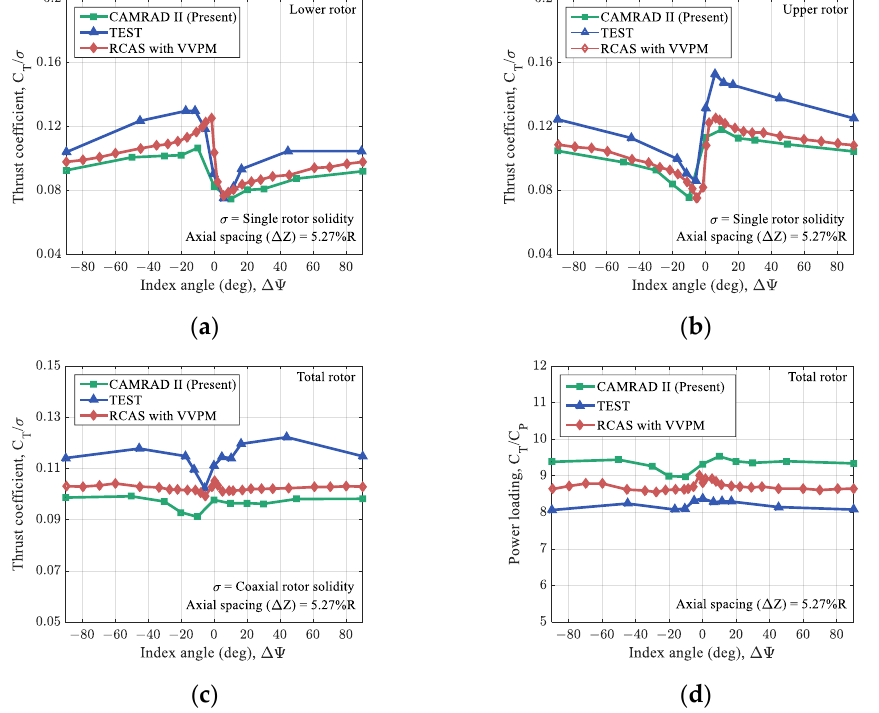
Figure 9. Validation for hover performance analyses of coaxial co-rotating rotor in terms of index angle with previous results [21] (collective pitch angle = 12 ◦ ): ( a ) Lower rotor thrust ( C T / σ ); ( b ) upper rotor thrust ( C T / σ ); ( c ) total rotor thrust ( C T / σ ); ( d ) total rotor power loading ( C T / C P